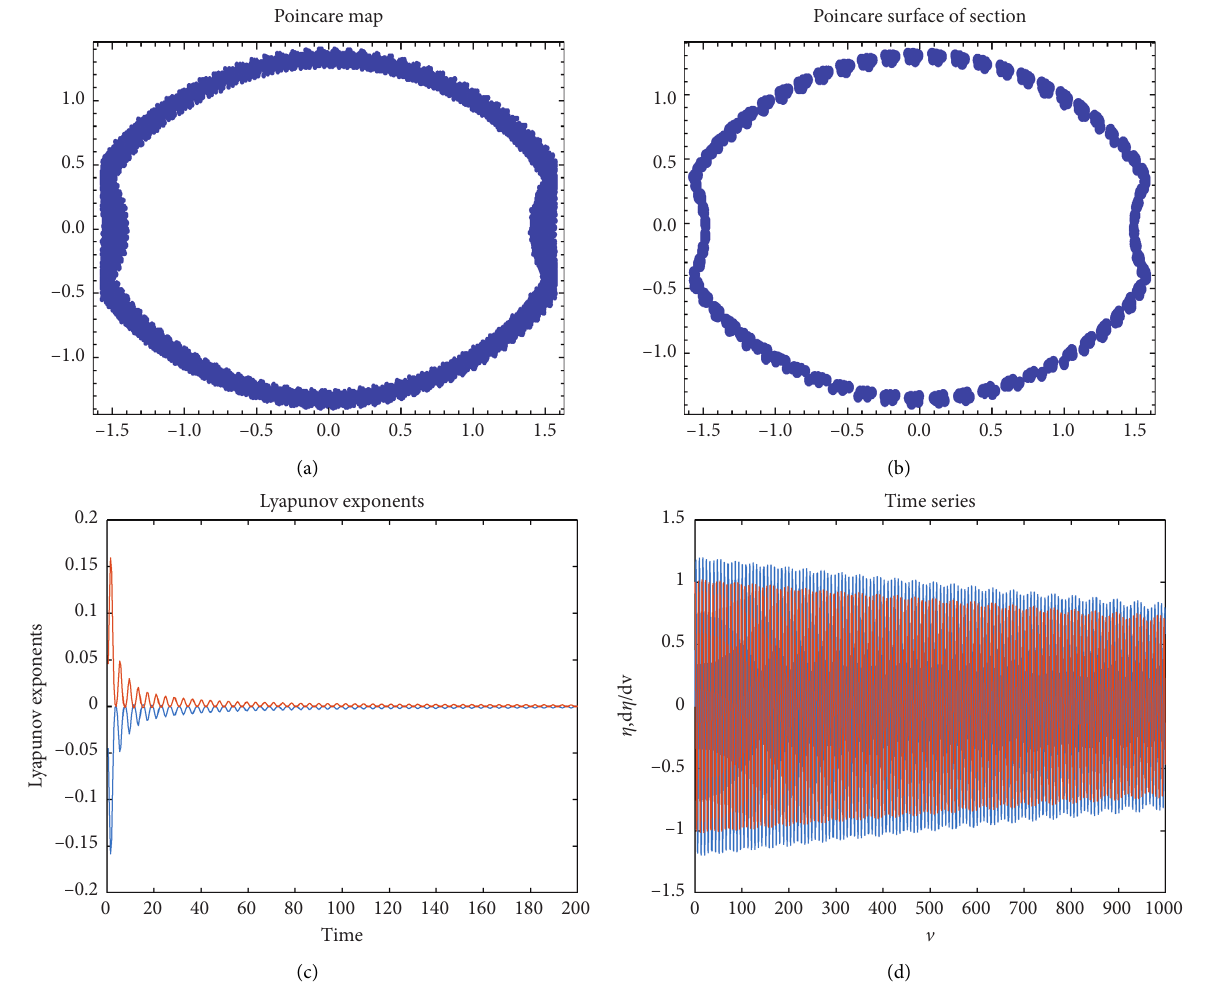
� 3 . 36 E + 09 , D � − 4 E + 08 , B � 1596 . 387 , C � − 103631 ,E � 200 . 1022 , ∗ ∗ ∗ ∗ ∗